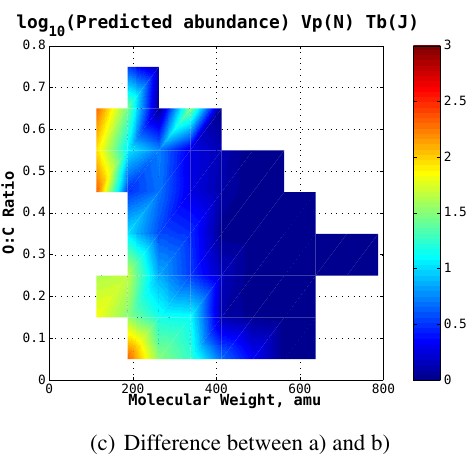
Fig. 9. Predicted condensed organic component mass plotted as a function of molar mass and O:C ratio from a single initialisa- tion. When using the JR technique, it can be seen that the varia- tion in component mass from the base prediction is not uniformly distributed.